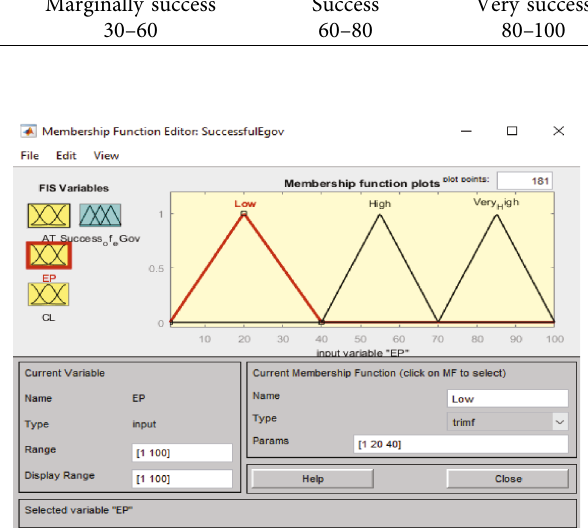
Figure 4: Fuzzification for EP.